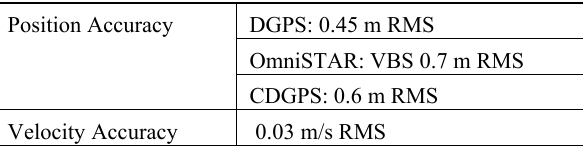
Table 3: NovAtel receiver specifications